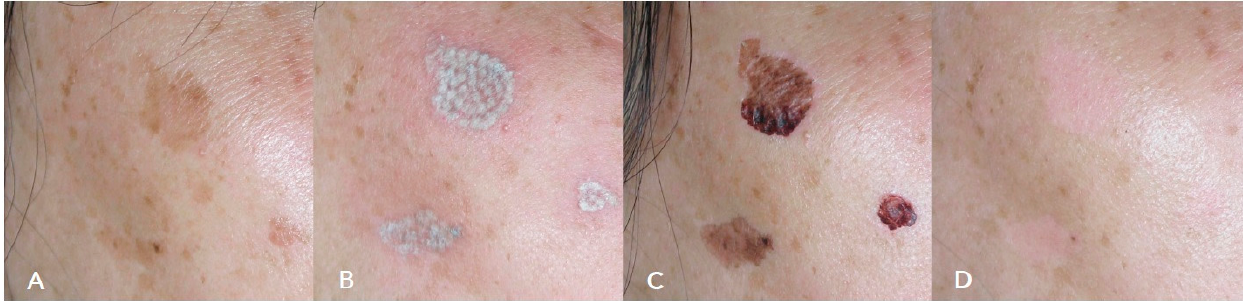
Table 1. Patients’ characteristics.